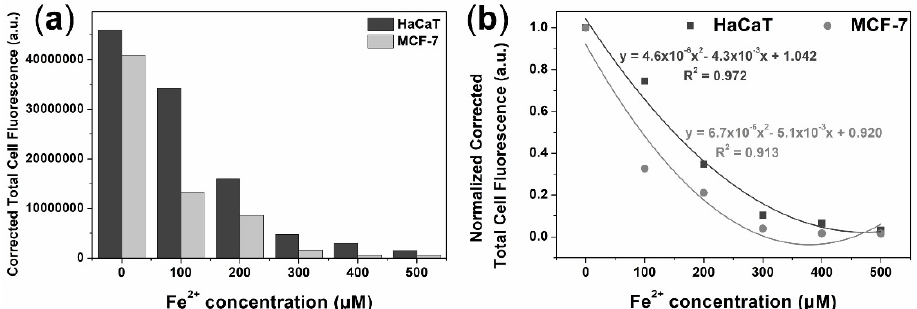
Figure 6. ( a ) Semi-quantification of fluorescence staining intensity for the monitoring of intracellular ferrous ion in HaCaT cells and MCF-7 cells. ( b ) Correlation between intracellular Fe 2+ ion concen- tration and normalized corrected total cell fluorescence.